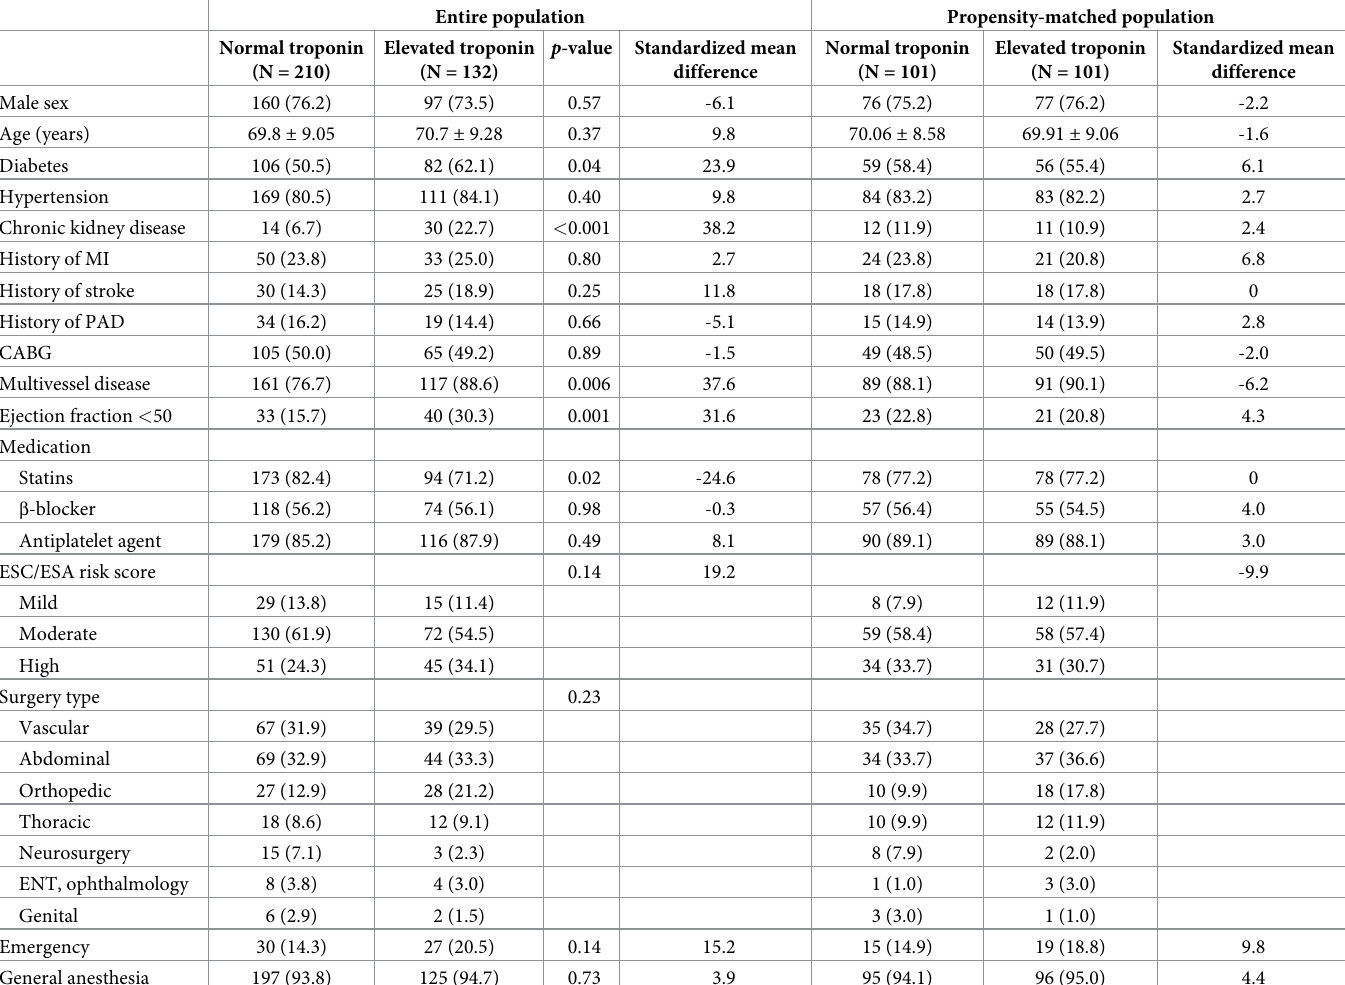
Table 5. Baseline characteristics of the postoperative